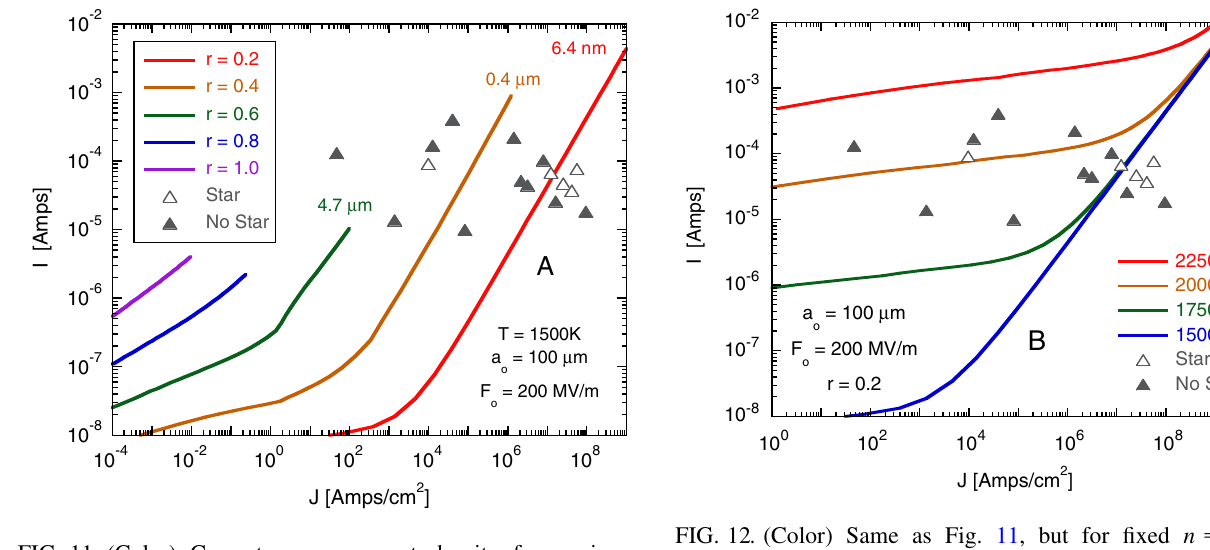
FIG. 11. (Color) Current versus current density for a given background field and temperature as the value of n (number of point charges) increases. Numbers at the topmost end of the lines are the apex radii. ‘‘Star’’ and ‘‘No Star’’ are data points from Fig. 1 of Wilson (page 3 of Ref. [37]) for conditions leading to starburst formation and are provided for comparison. Increasing n along such lines mimics asperity ‘‘growth.’’